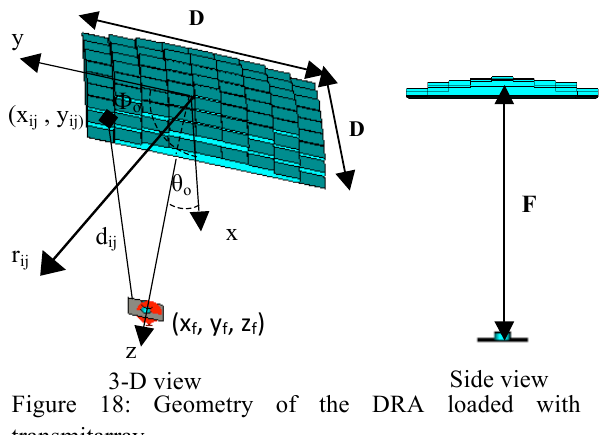
Figure 17: The E- and H- planes of circular polarization radiation patterns for the DRA loaded with dielectric sphere compared to a single DRA at f = 10 GHz.